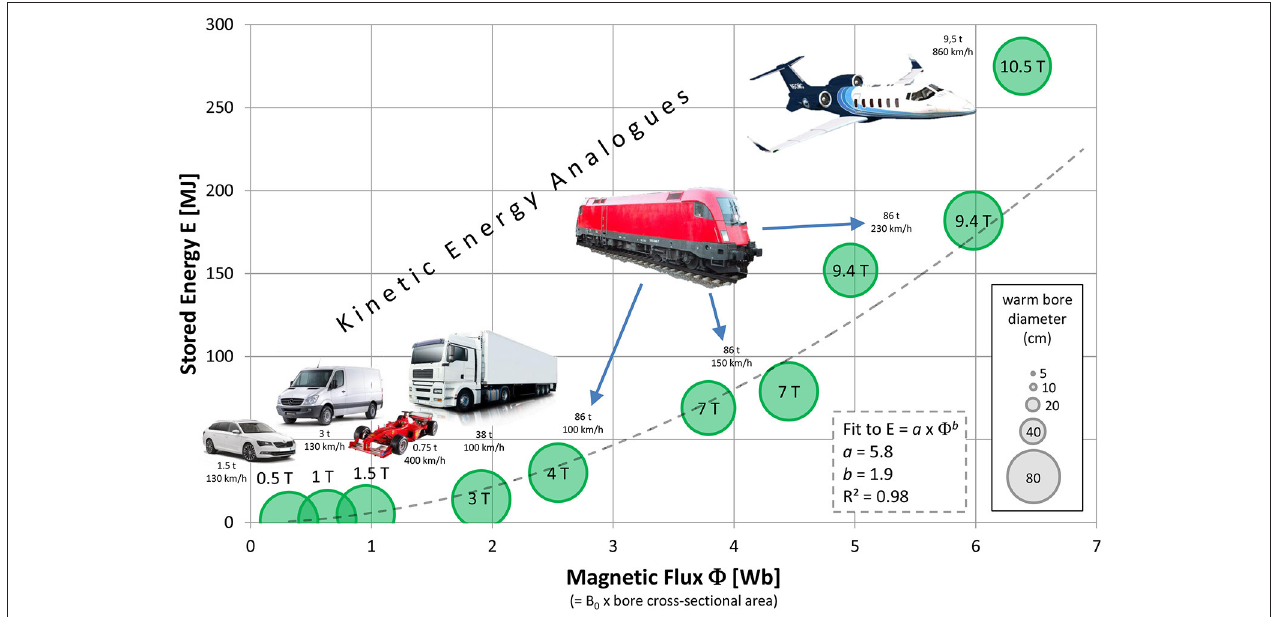
FIGURE 3 | Amount of energy stored in the magnet vs. magnetic flux (calculated from the warm bore diameter), showing an empirical trend of quadratic increase (dotted line). For illustration, everyday analogs in the form of vehicles with kinetic energy similar to the stored energies are depicted with their respective masses and velocities. Data and references for all data points are given in the Supplementary Materials. Please note that more precisely, the diameter of the magnet coils instead of the warm bore diameter should have been used for the calculation of magnetic flux; unfortunately this data could not be retrieved. However, when adding a constant offset in the range of 5–15 cm to the bore diameters for all data points, the fit still yields the quadratic dependence and only differs in its steepness a